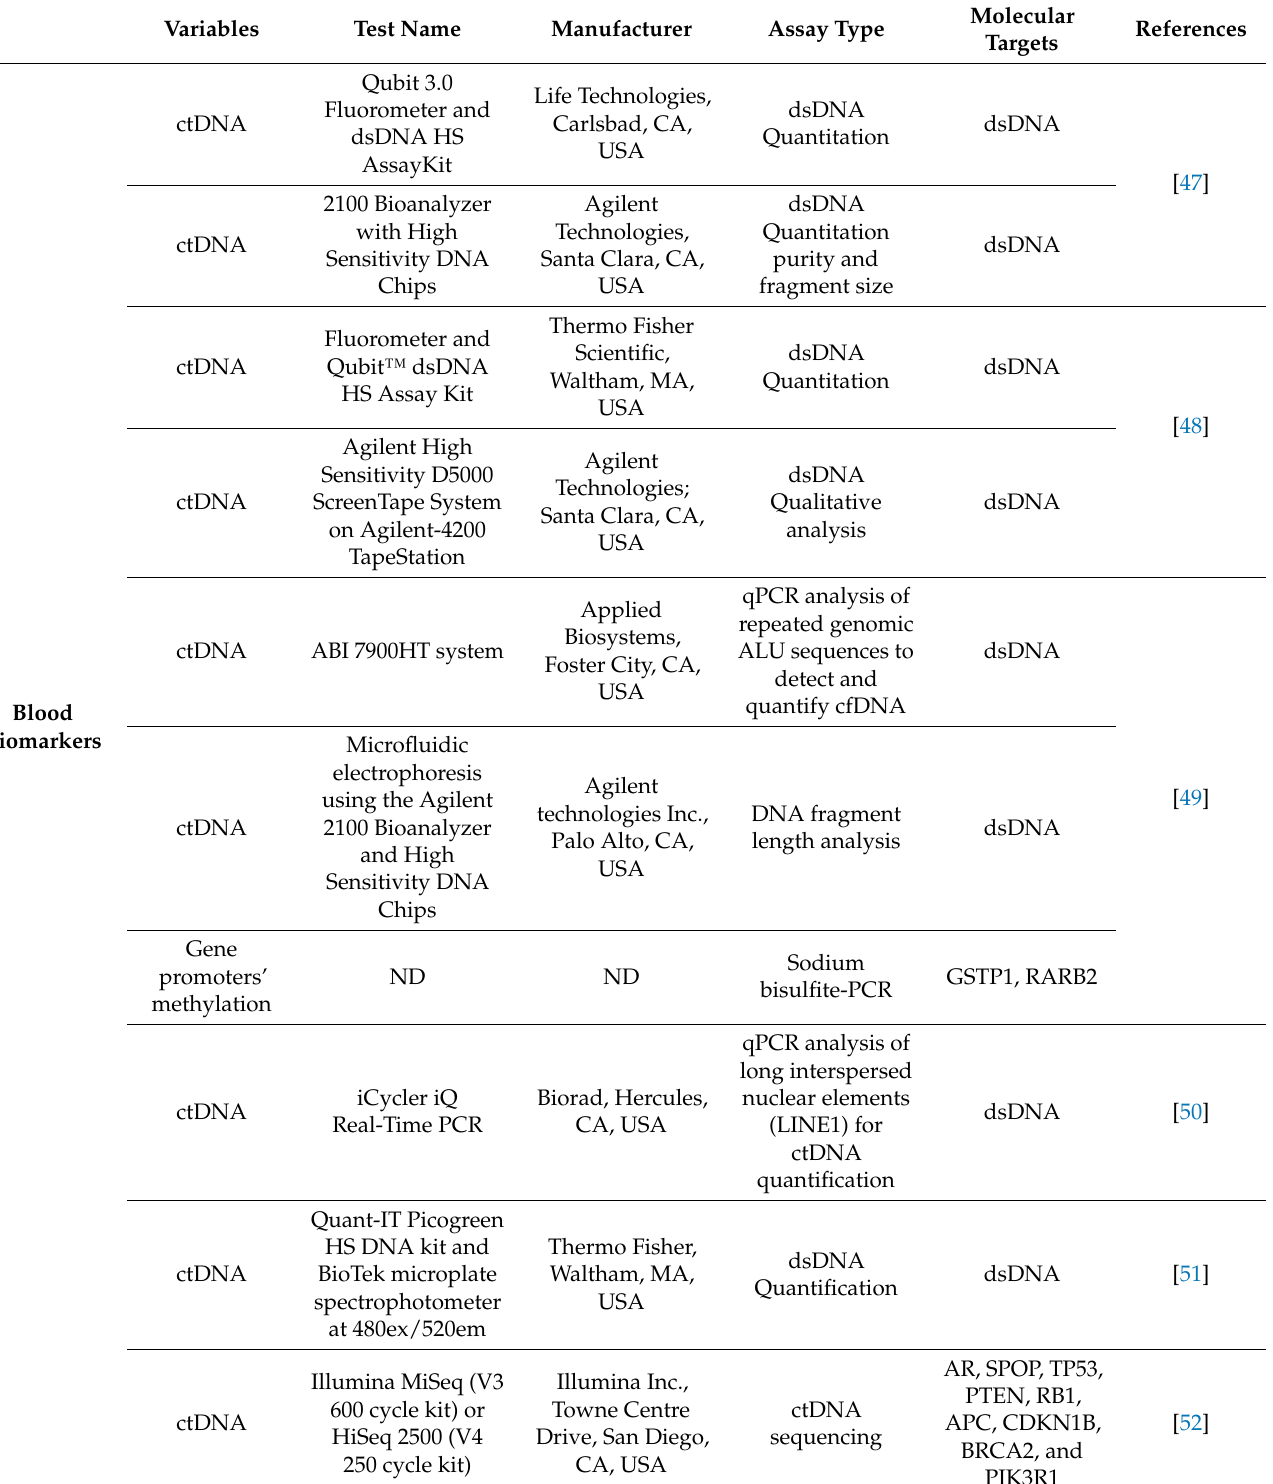
Table 1. Summary of blood, serum and urine